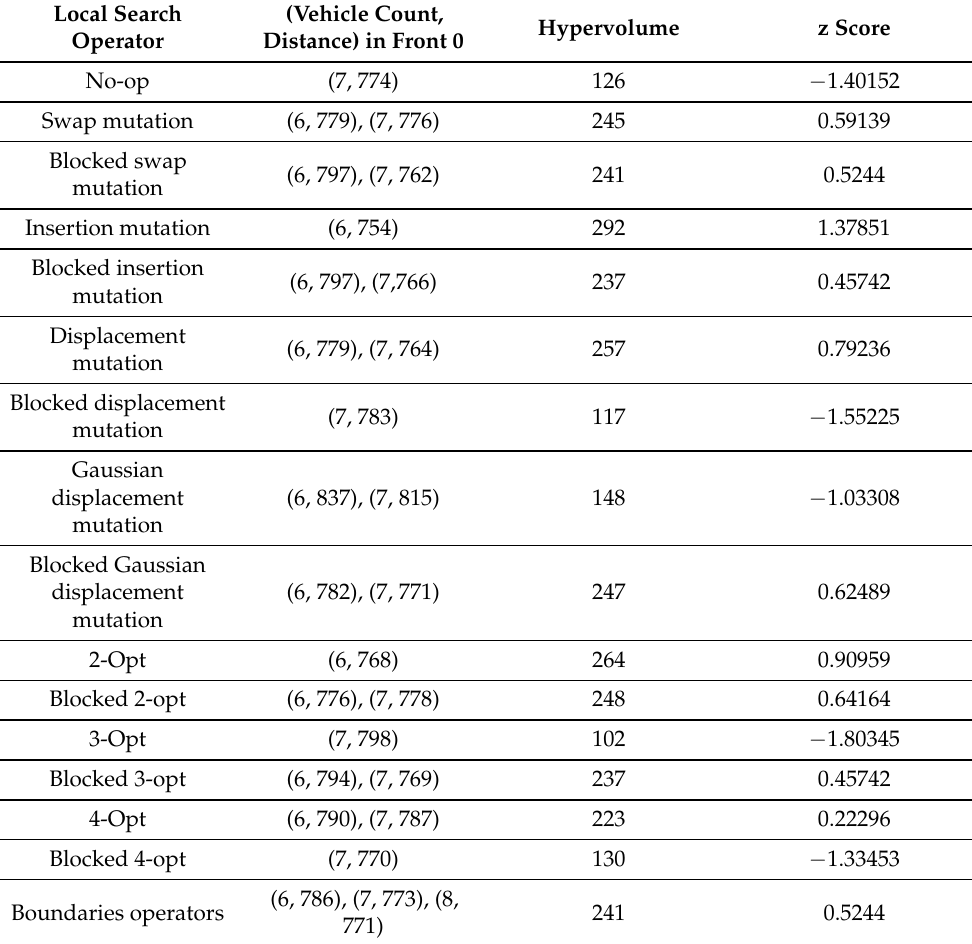
Table 6. Local search operators effects on solution quality of bar-n100-1